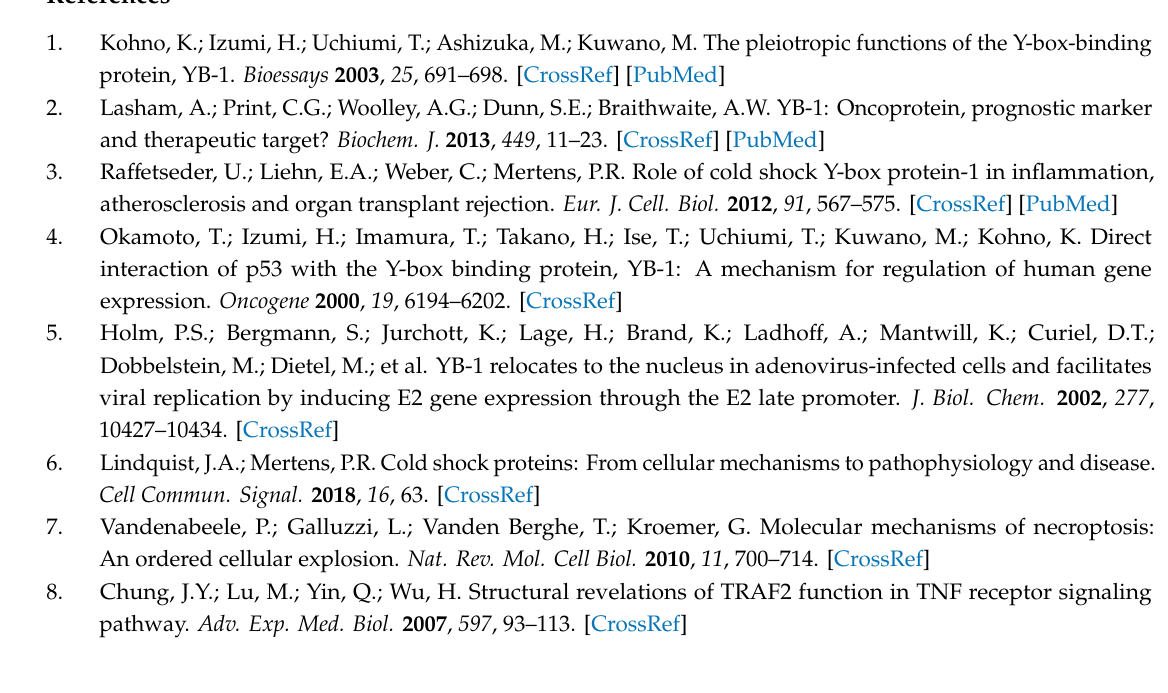
Figure S1: YB-1 is essential for TNF-induced NF- κ B nuclear translocation in a human monocytic cell line (THP-1). Figure S2: Representative single images each selected from fields of view from the time lapse microscopy, Figure S3: YB-1 knockdown enhanced caspase activation, Figure S4: YB-1 knockdown enhanced caspase activation; whole blots are provided, Supplementary movies from the time lapse microscopy are also provided. Video S1: CTRL. Video S2: KD. Video S3: CTRL TNF + CHX. Video S4: KD TNF +